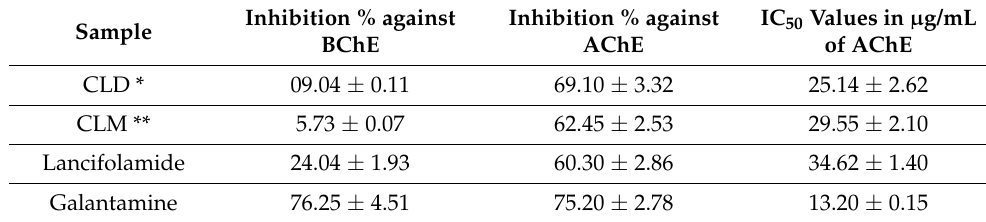
Table 6. Assay of Anticholinesterase at 200 µ g/mL Mean ± SD (n =